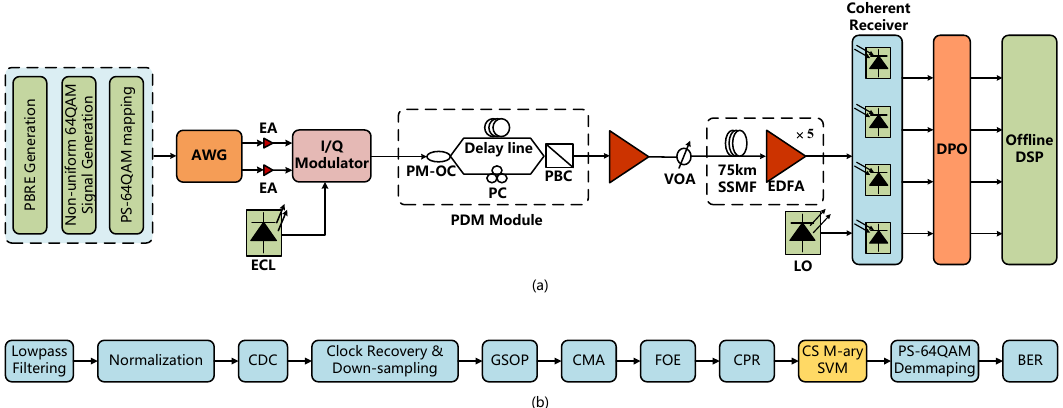
Figure 8. ( a ) The experimental setup for the 120 Gb/s PS-64QAM coherent optical communication system; ( b ) offline DSP flow chart.